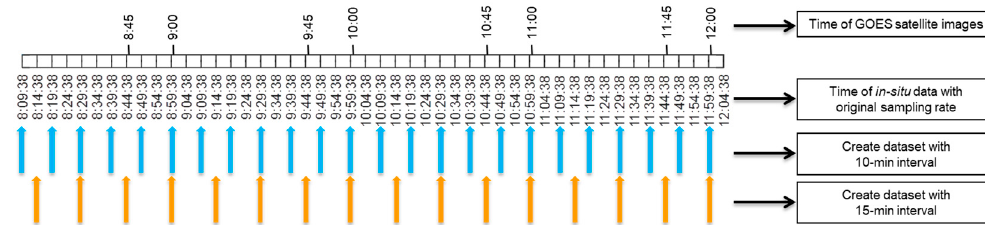
Figure 2. Graphical representation of the decimation procedure used to create UTSA datasets with 10-min and 15-min time intervals from the original 5-min dataset. The time of the GOES satellite images are also indicated in the figure.